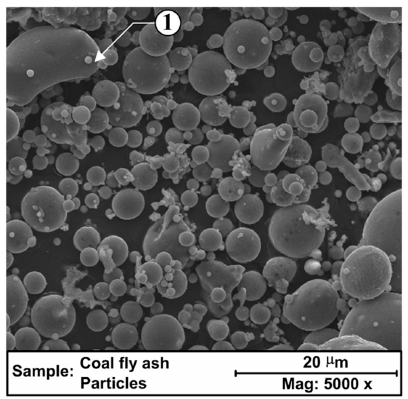
Figure 5. SEM image of typical fly ash composed of mainly spherical particles and 1- some irregularly shaped grains (reproduced from ref. [113] with permission from Elsevier). Fly ash is a heterogeneous material, with major components of SiO 2 , Al 2 O 3 , Fe 2 O 3 , and CaO [114]. The exact composition of fly ashes varies depending on the origin of the coal from which it is derived. Fly ash is composed predominantly of a glassy phase alongside phases of quartz, mullite, maghemite ( γ -Fe 2 O 3 ), hematite ( α -Fe 2 O 3 ), periclase (MgO), rutile (TiO 2 ), gehlenite (Ca 2 Al 2 SiO 7 ), and anhydrite